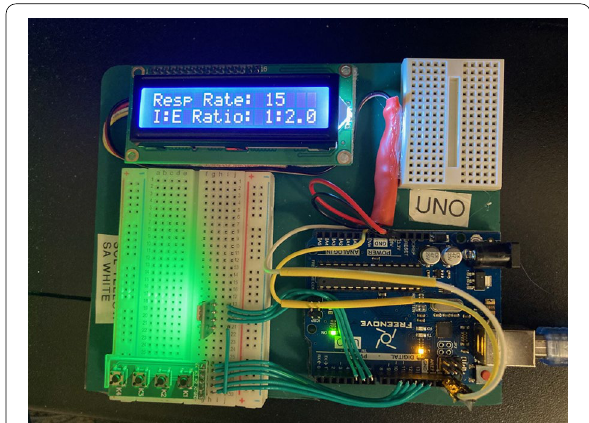
Fig. 5 Photograph of the prototype for the advanced system corresponding to the code in Fig. 4. Note the presence of a 2-line by16-character LCD display (for displaying the respiratory rate and I:E ratio) as well as a 4 1 array of pushbuttons (K1, K2, K3 and K4) × used to setup (initialize) the operation of the unit. Notice also the